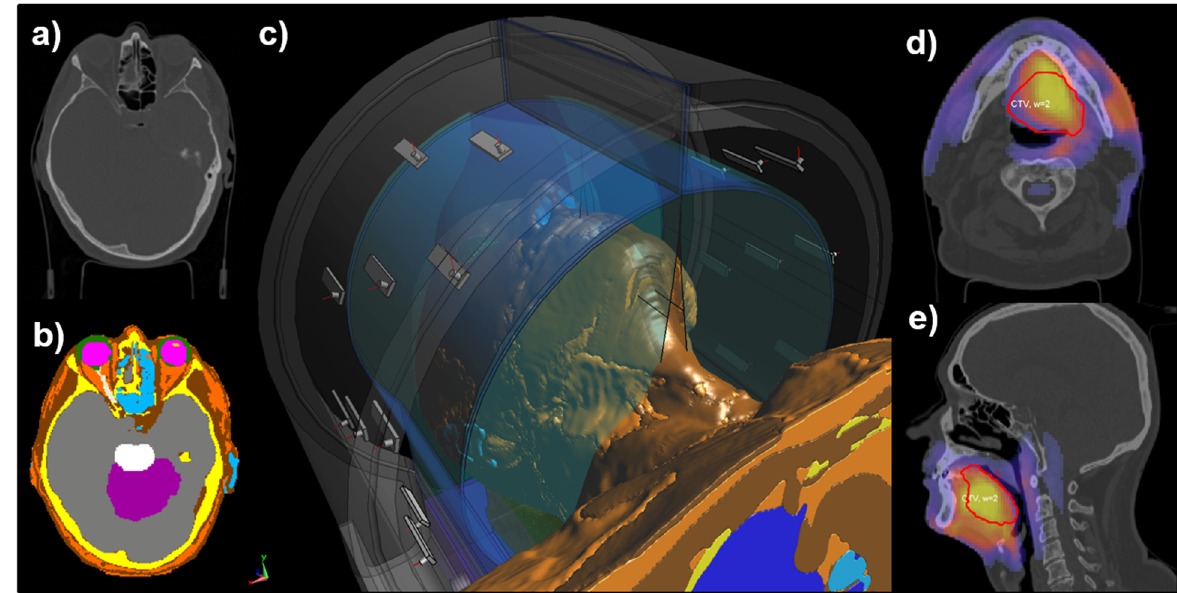
Figure 2. Overview of the Erasmus MC procedure of hyperthermia treatment planning for H&N hyperthermia with the HYPERcollar3D applicator. ( a ) example of axial CT slice, ( b ) corresponding segmentation in iSeg, ( c ) hyperthermia treatment planning setup in SEMCAD X, ( d ) axial and ( e ) sagittal slices of SAR with highlighted target region. Table 1. Dielectric properties at 434 MHz [13], thermal properties for 37 °C [14], * optimized values from ten patients treated with HYPERcollar applicator [15], the lung and internal air were in temperature simulations inactive and mod- eled using temperature boundary conditions. The values for tumor blood perfusion of 72.3 (mL min − 1 kg − 1 ) was obtained by scaling muscle perfusion by factor of 1.85 following muscle-tumor difference at 37 °C from [16]. Tissue